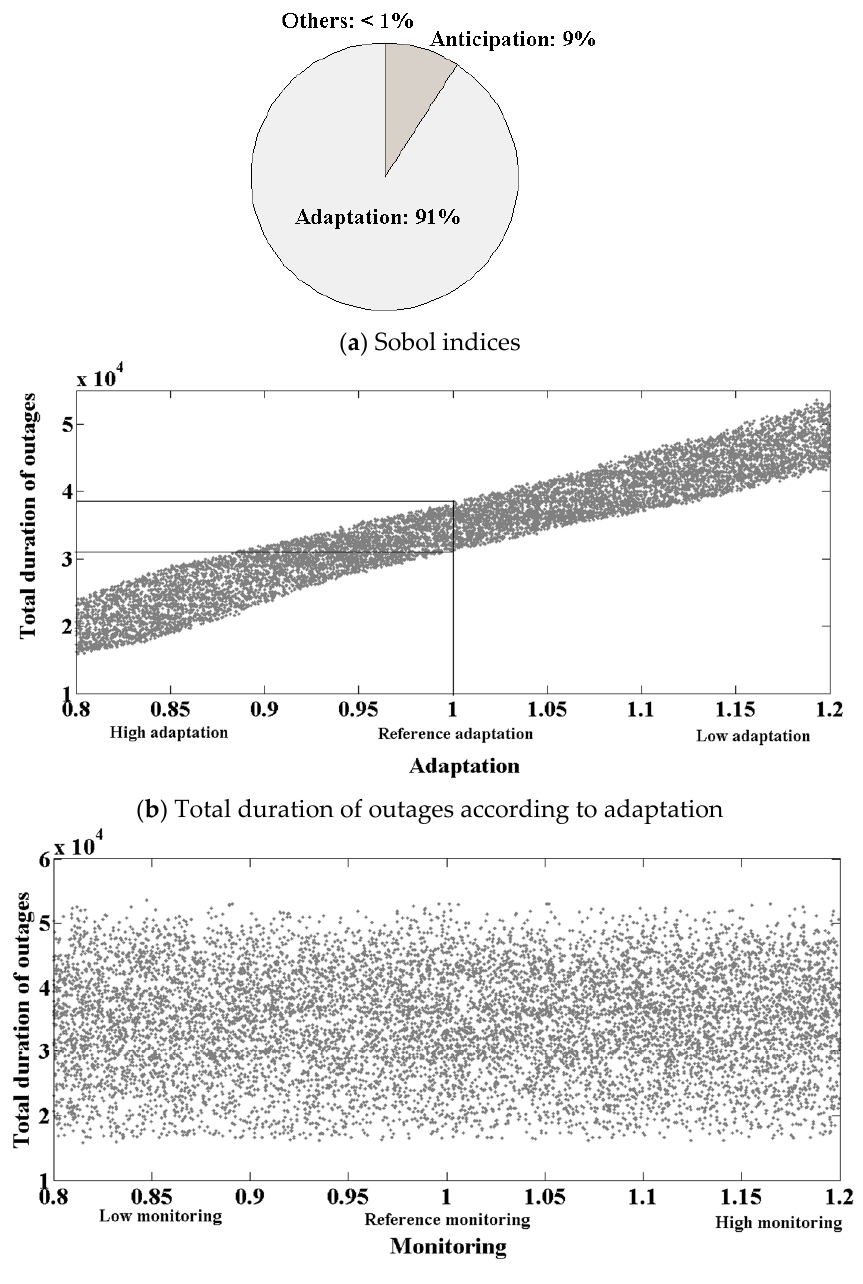
Figure 7. Influence of the different processes on the total duration of outages. In ( a ), Sobol indices of the different processes are shown. Adaptation is the most influential process here, followed by the anticipation process. In our case, the second-order Sobol indices are very low, showing a low dependency of the processes. Influences of adaptation and monitoring are also represented around a normalized reference (more or less 20%). Results are confirmed in ( b , c ), from which we can see that total duration of outages clearly depend on adaptation.